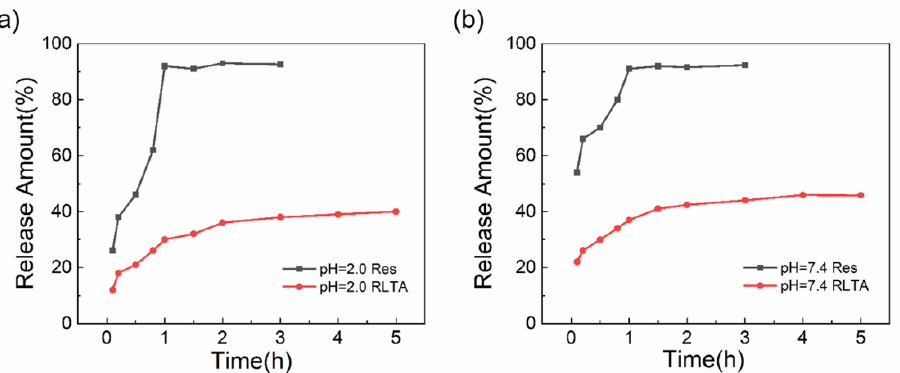
Figure 3. Simulated release diagrams of Res and RLTA under different conditions: ( a ) artificial gastric juice pH = 2.0. ( b ) phosphate buffer pH = 7.4.